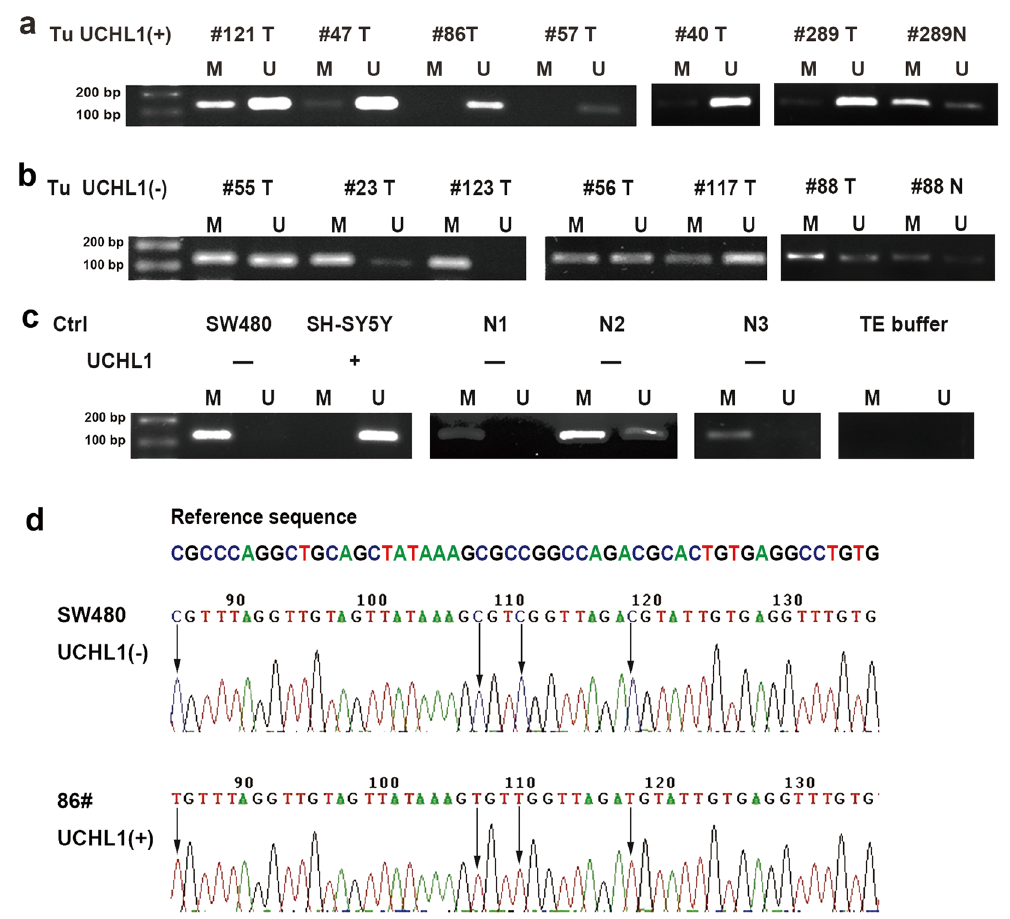
Figure 3. Promoter methylation of UCH-L1 in cancer cell lines and PNETs. The methylation of UCH-L1 promoter was more common in tumors without expression of UCH-L1 protein and para-tumor tissues (#289 N, #88 N). Demethylation was frequently seen in tumours with UCHL1 expression. U: unmethylated; M: methylated. Cell lines SW480 and SH-SY5Y were used as methylation and unmethylation controls, respectively, and TE buffer as blank control. Sequencing PCR products confirmed the MSP